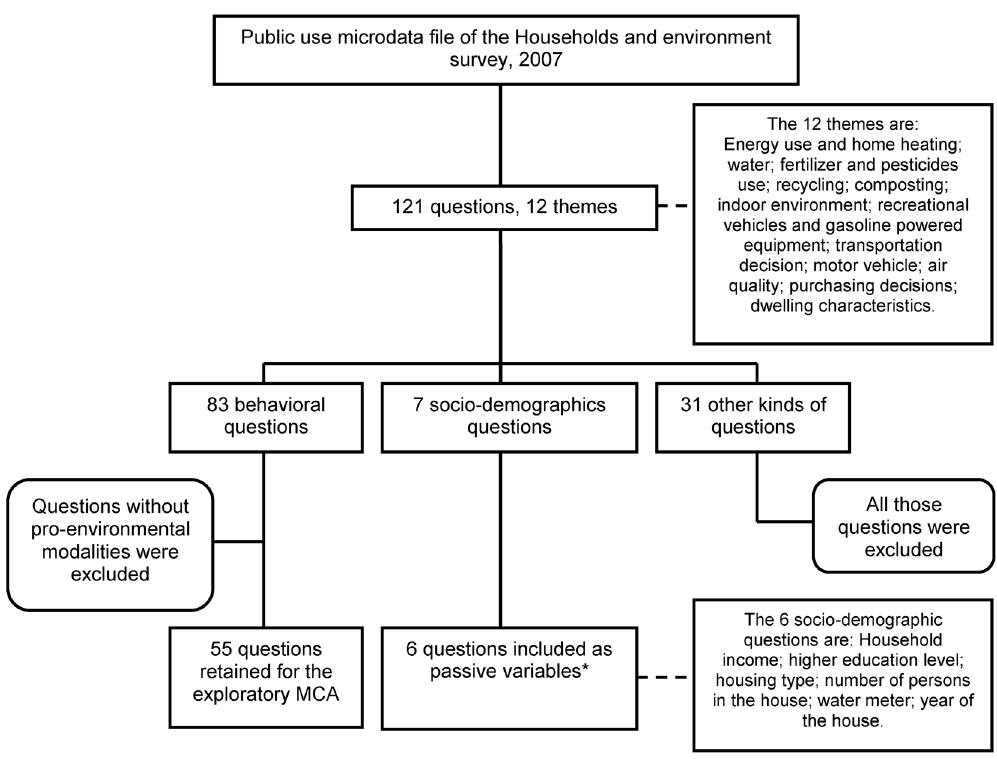
Figure 1. Number and type of questions selected to develop the composite index. Legend: *The composite index was also created for the 7th socio-demographic variable, the census metropolitan area (n=33), but is not presented in this article.